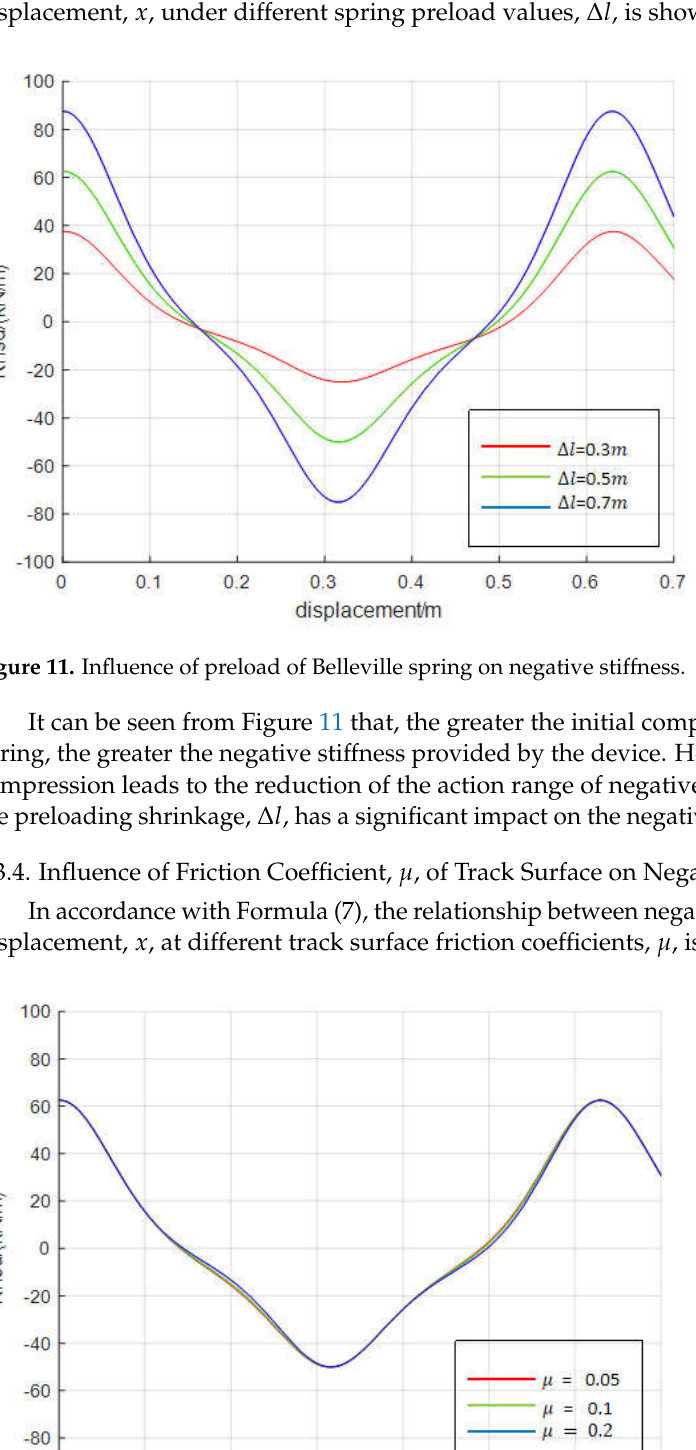
Figure 10. Effect of spring stiffness on negative stiffness.